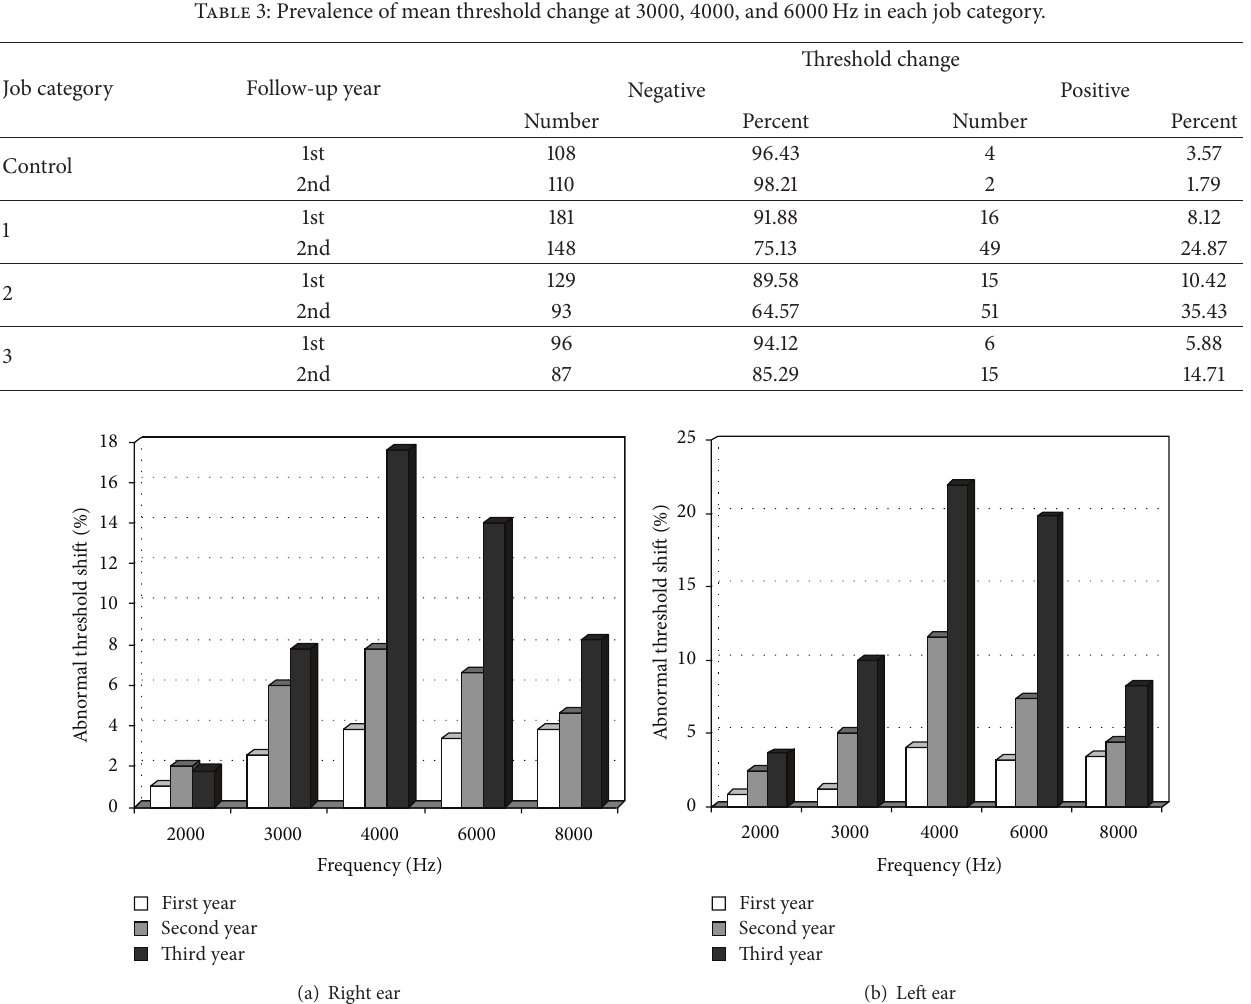
Figure 2: Percentage of abnormal hearing threshold ( > 20dB) in different frequencies in right and left ears in different years of